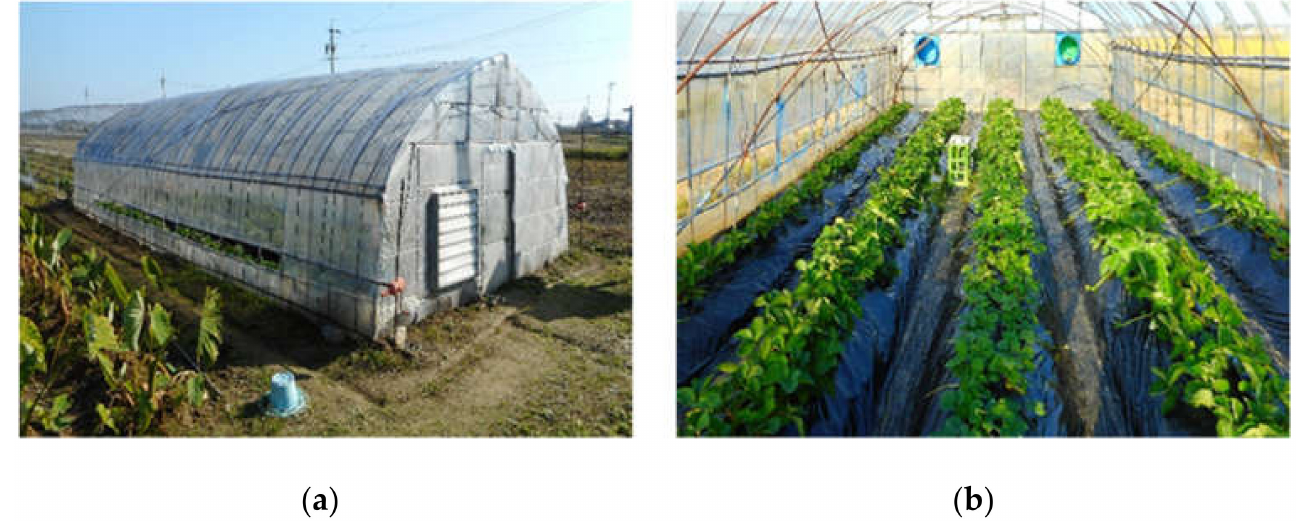
Figure 1. Experimental greenhouse: ( a ) external view; (b ) inside view.